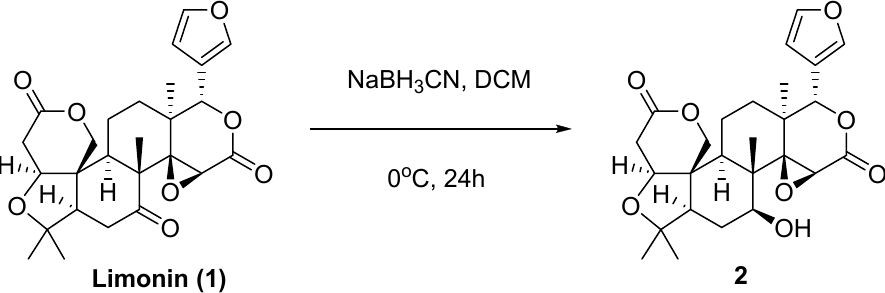
Figure 3. Hydrogenation of limonin by sodium cyanoborohydride.